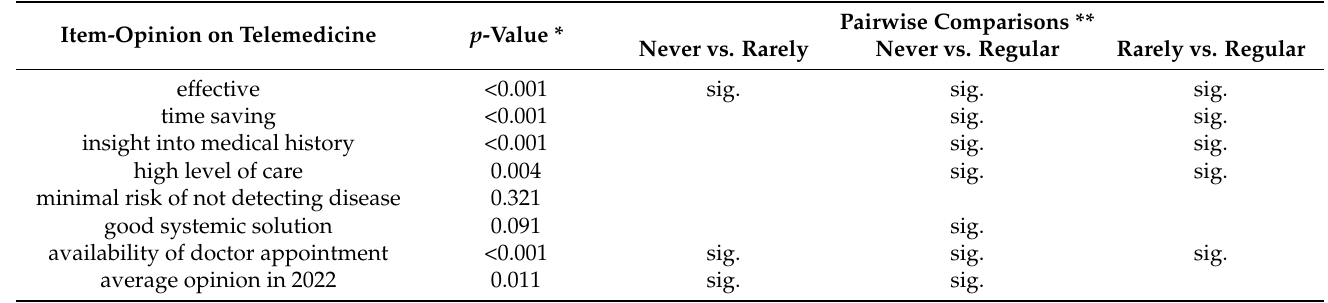
Table 3. Results of testing comparisons of telemedicine assessments after two years of the pandemic (summarized).